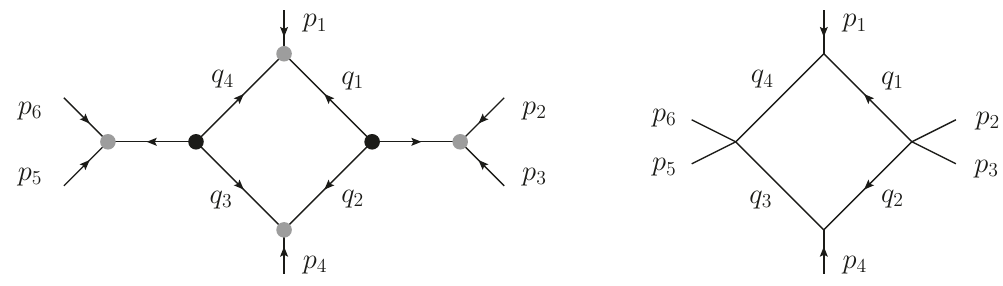
Figure 9 . L.h.s.: one-loop six-leg supergraph of the MHV type. R.h.s.: the corresponding Feynman integral representing the bosonic factor